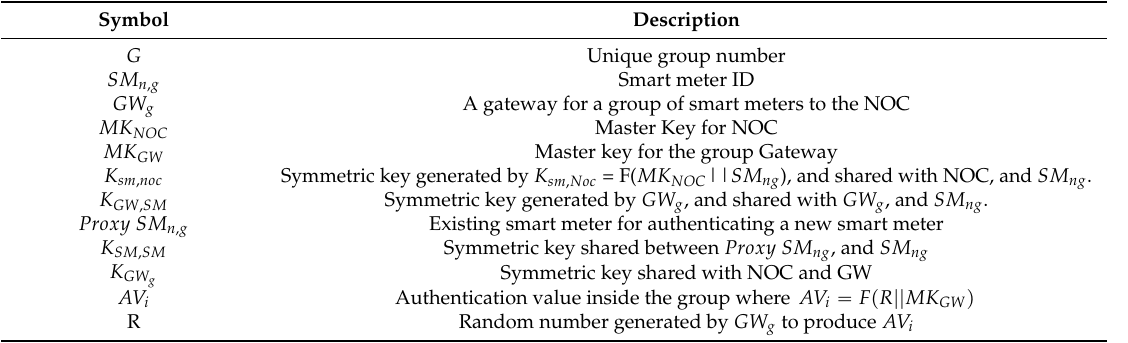
Table 2. Notations for the authentication scheme for the NAN.